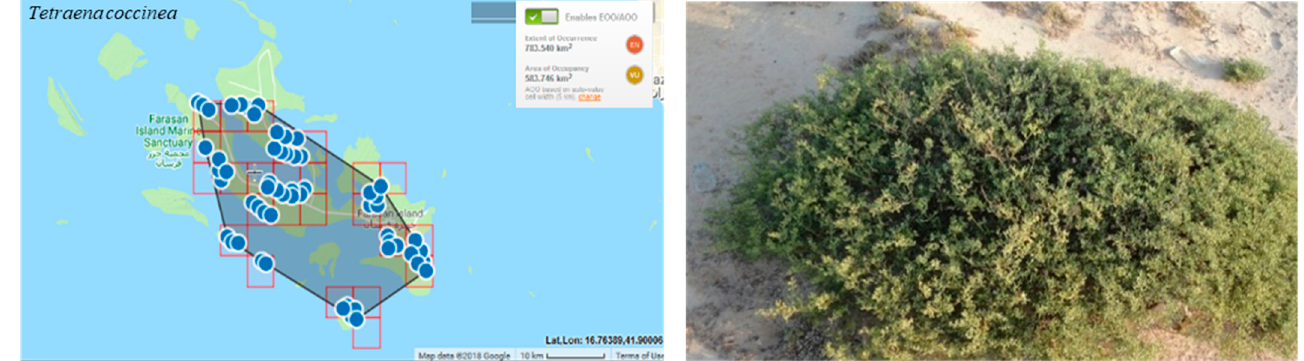
Figure 7. Geographical distribution of Tetraena coccinea in the Farasan Archipelago (plant photo by R. Al-Qthanin from Faranan Alkabir